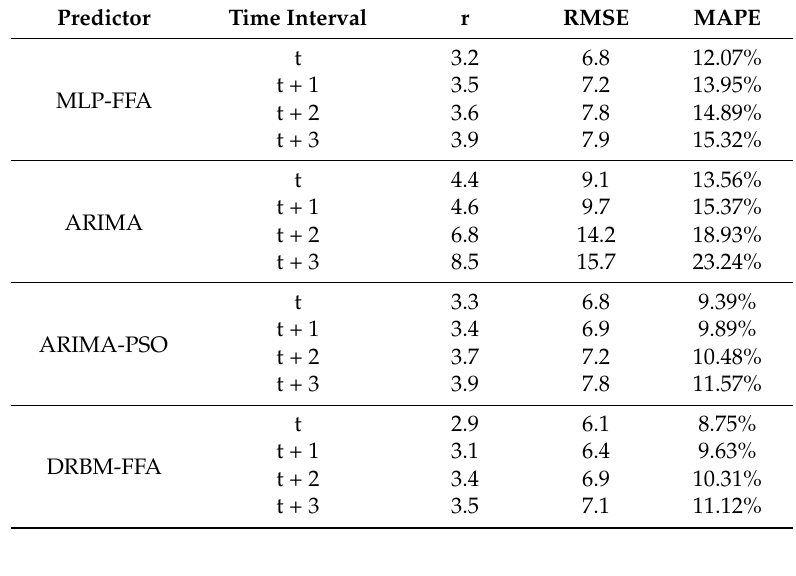
Table 4. Traffic flow prediction results.